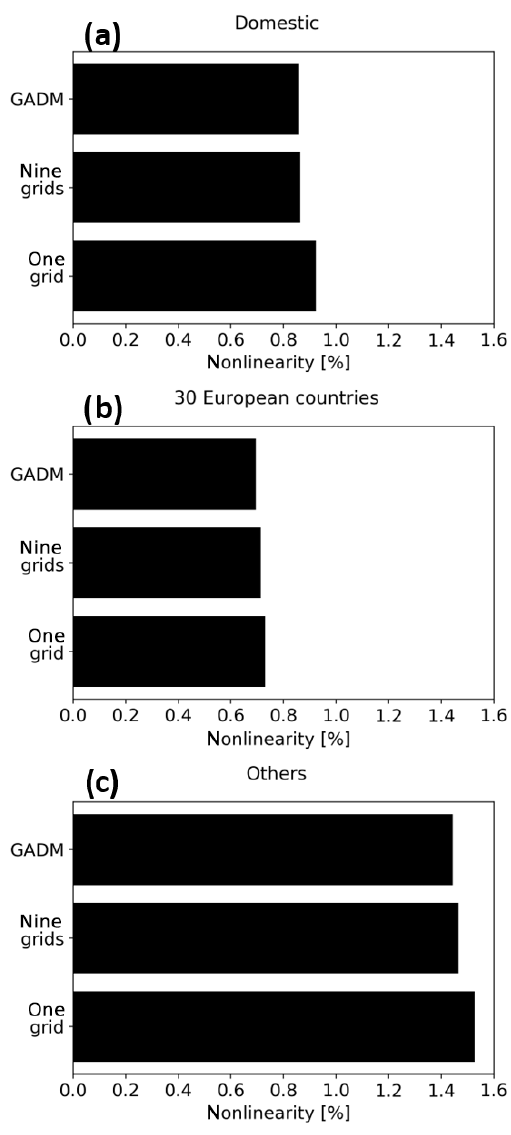
Figure 7. The black horizontal bars show the mean nonlinearity calculated for each contribution presented in Fig. 6 and for the three city definitions. The nonlinearity is calculated for each hourly concentration as the standard deviation of the hourly contribution weighted by the hourly total